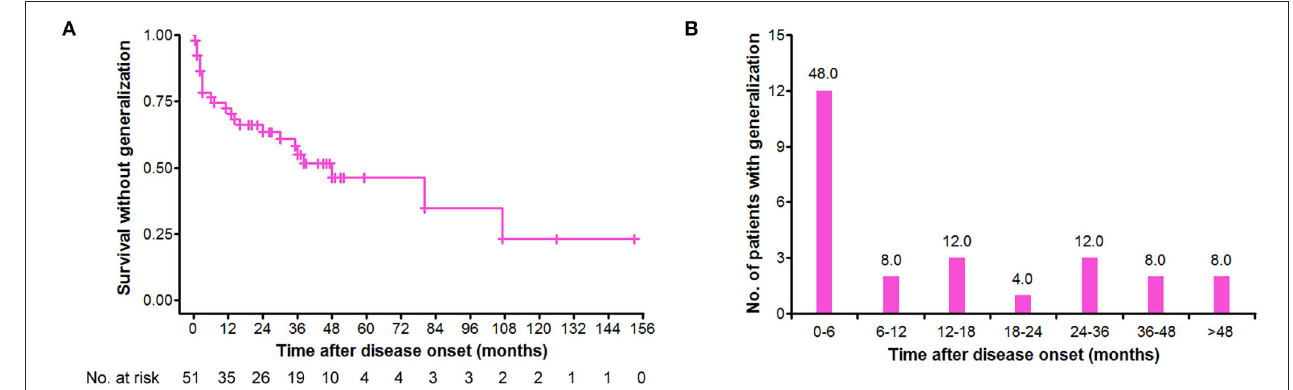
FIGURE 2 | Distribution of secondary generalization in the patients with v-LOMG with pure ocular onset. (A) Kaplan–Meier curve depicting the cumulative survival without generalization over time (months). (B) Time distribution of generalization in the 25 patients with v-LOMG. Y -axis indicates the number of patients undergoing generalization with the percentage showing on the top of each